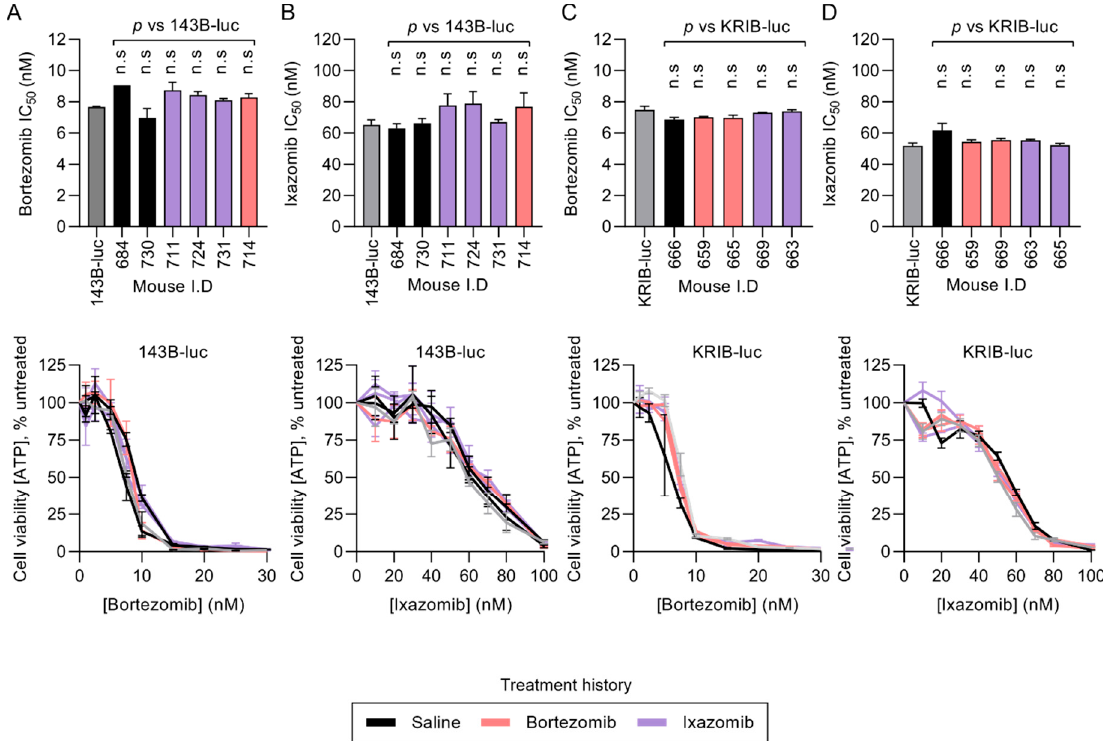
Figure 6. Cells from resected KRIB-luc and 143B-luc lung tumors are as sensitive to proteasome inhibitors as parental cells that have not been implanted in mice, regardless of in vivo treatment history. 143B-luc ( A , B ) and KRIB-luc ( C , D ) lung tumors were resected from mice following 4 weeks of treatment with saline, ixazomib or bortezomib. Cells isolated from resected tumors (black and colored columns), and in vitro-cultured cells (gray columns), were exposed in vitro to a range of concentrations of bortezomib ( A , C ) or ixazomib ( B , D ) and residual ATP was measured to assess sensitivity. Two-way ANOVAs with Bonferroni corrections were used to determine the probability that differences in the sensitivity of cells from resected tumors compared to naïve parental cells were due to random chance (n.s p > 0.05); n = 3 technical replicates +/ − SEM).